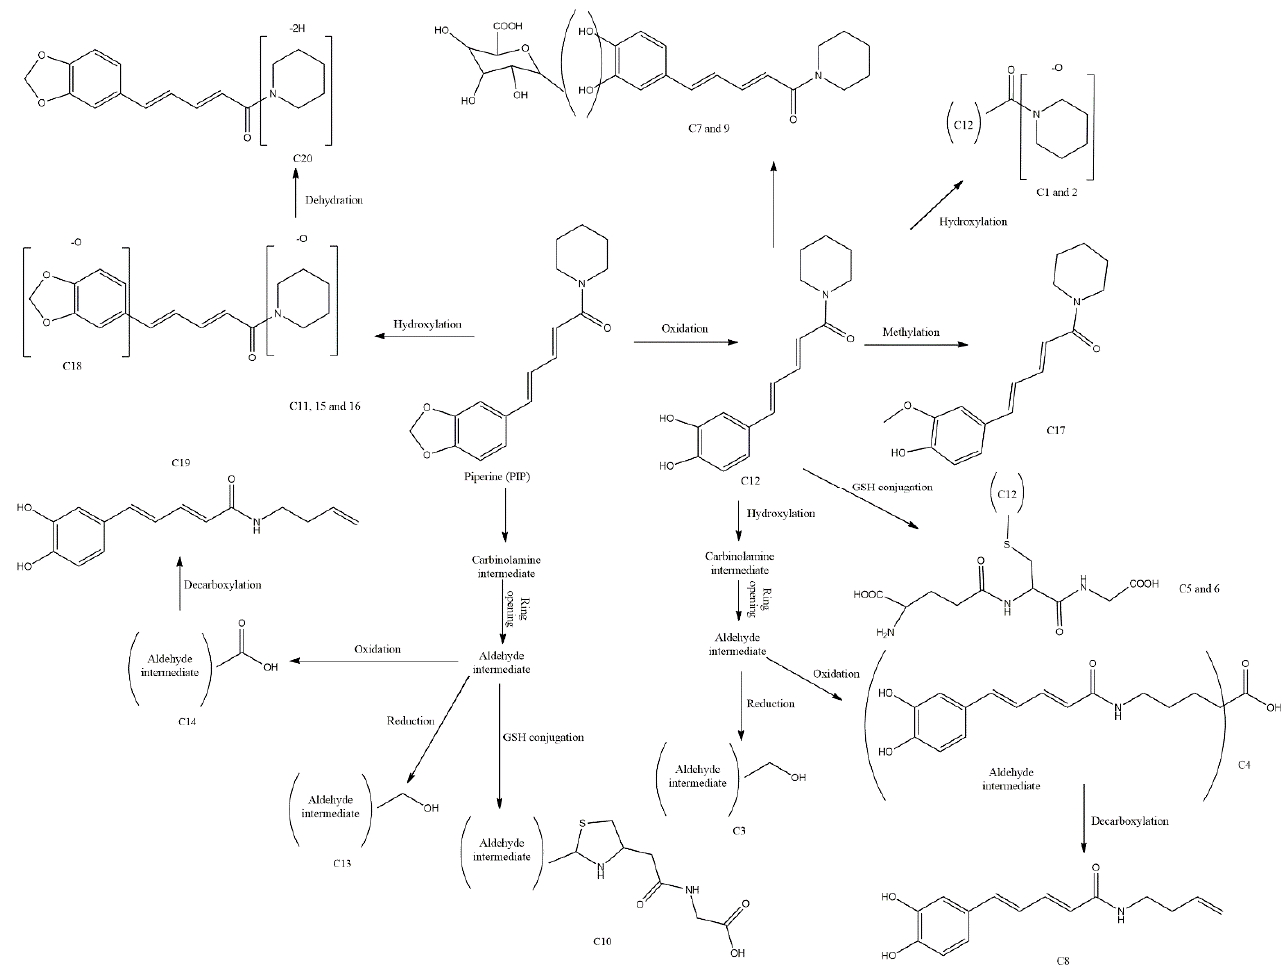
Figure 2. Possible biotransformation of PIP metabolites in hepatocyte. Based on Li Y et al . [28], 20 metabolites could be detected from PIP in the liver. Li and colleagues used hepatocytes of four different species (human, rat, mouse, and dog) and found that a few of these 20 metabolites could be detected in all species (C6, C9, C11, C12, C13, C14, C15, C19, and C20), but not all. C1–5, C7, and C17 were found to be present in both mouse and rat species, while C10, C16, and C18 were exclusively present in mouse. Metabolite C8 was observed only in rat hepatocyte. Other than common metabolites for all species, C7 in human and C2–5 in dog hepatocytes were observed.